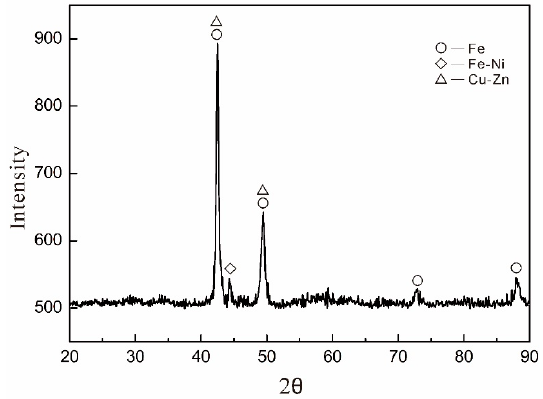
Figure 2. The phase structure of Fe-based diamond composite matrix.